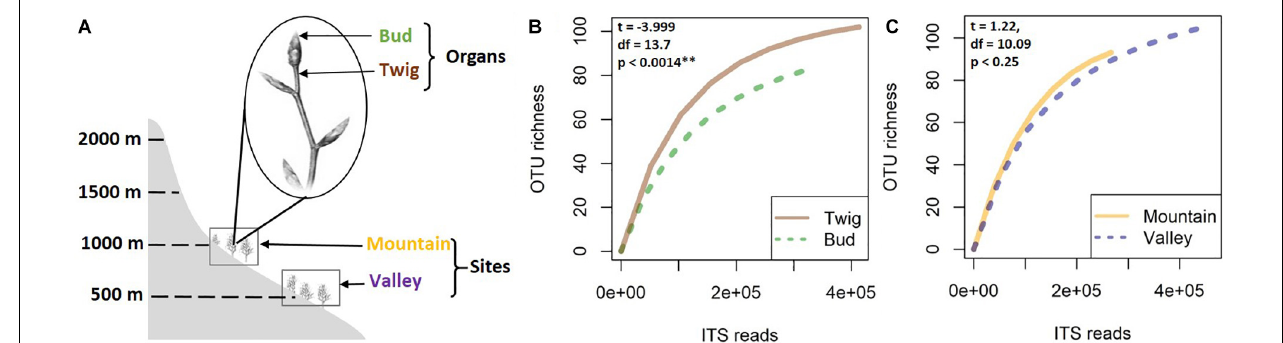
FIGURE 1 | For this study, samples of buds and twigs (the distal internode on a branch) were collected from 4-year-old beech trees at two study sites in Bavaria (A) . Species accumulation curves of fungal mycobiomes were analyzed according to organ (B) and site (C) . Higher species richness was indicated for twigs compared to buds, whereas only nonsignificant differences separated the